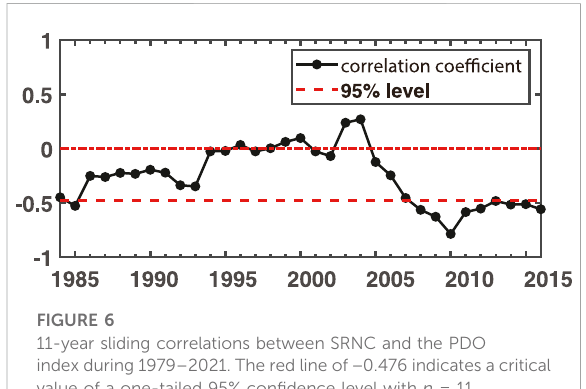
FIGURE 6 11-year sliding correlations between SRNC and the PDO